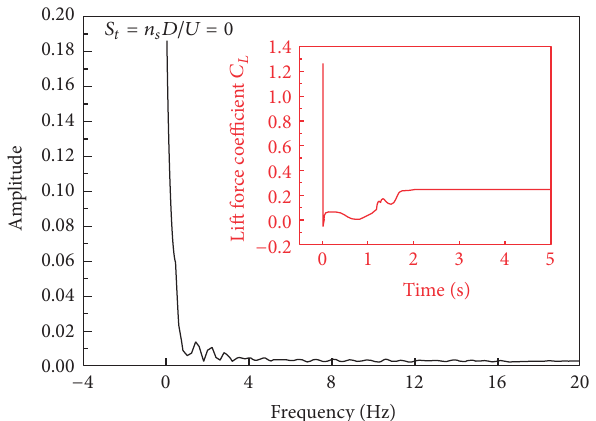
Figure 16: Power spectrum and time-history of the 𝐶 𝐿 (𝑡) of Case #2 under stationary condition ( 𝛼 = +3 ∘ , 𝑈 𝑟 = 1.094